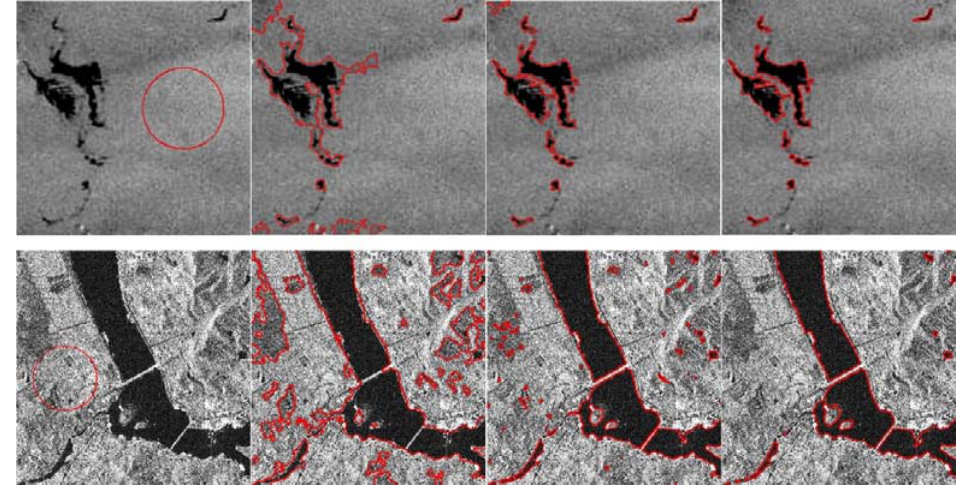
Figure 6. Segmentation results of the proposed method for real SAR images. Every row represents the process of curve evolution from the initial contour (in the first column) to the final contour (in the last column).